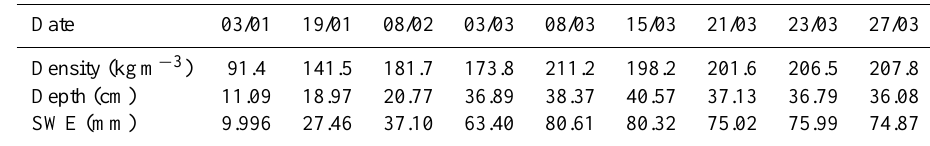
Table 1. Observed snow density, snow depth and Snow Water Equivalent (SWE) averaged over four transects within SNDWA, Saskatchewan, Canada (52.03 ◦ N, 106.1 ◦ W).